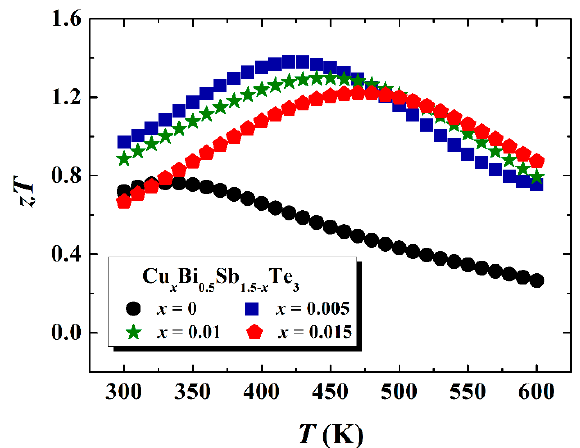
Figure 6. Temperature dependence of figure of merit zT for Cu-doped samples. The data for x = 0 and x = 0.005 are taken from [8]. x = 0.005 are taken from